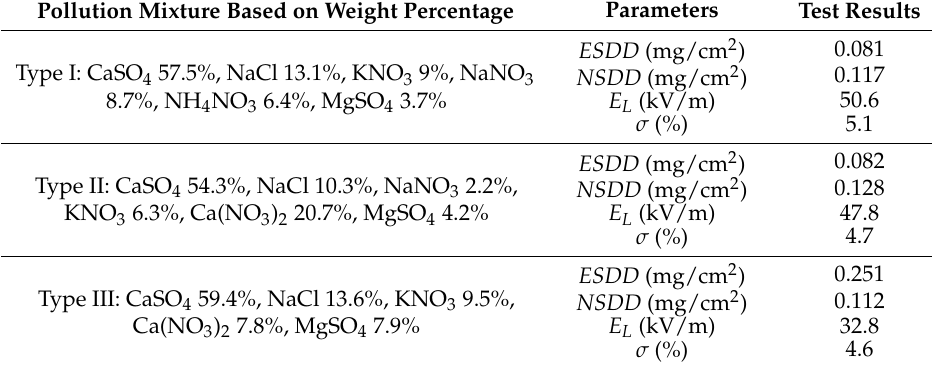
Table 6. Test results of insulator strings polluted with three types of soluble constituents mixture. Pollution Mixture Based on Weight Percentage